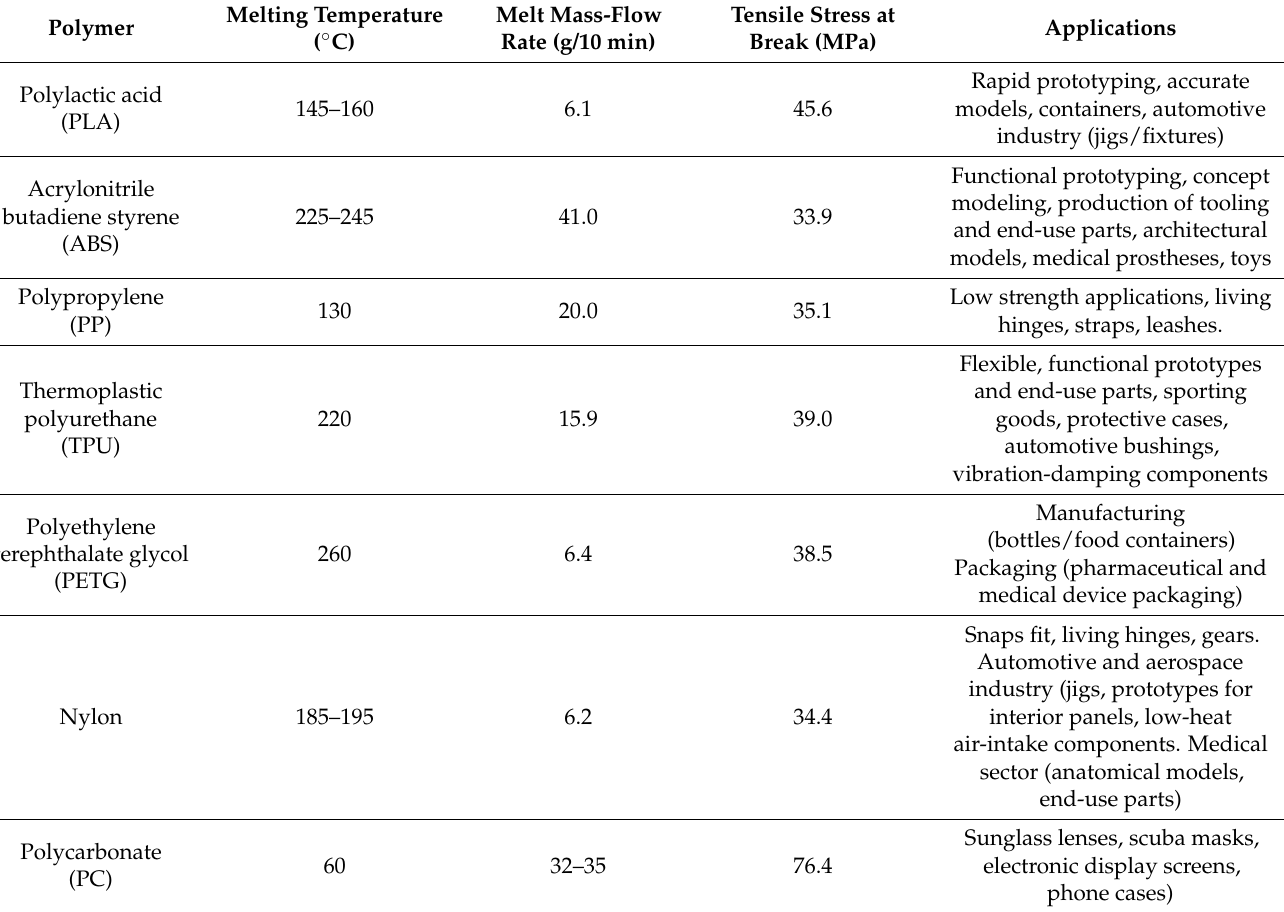
Table 2. Melting temperatures and some properties of different 3D printing common